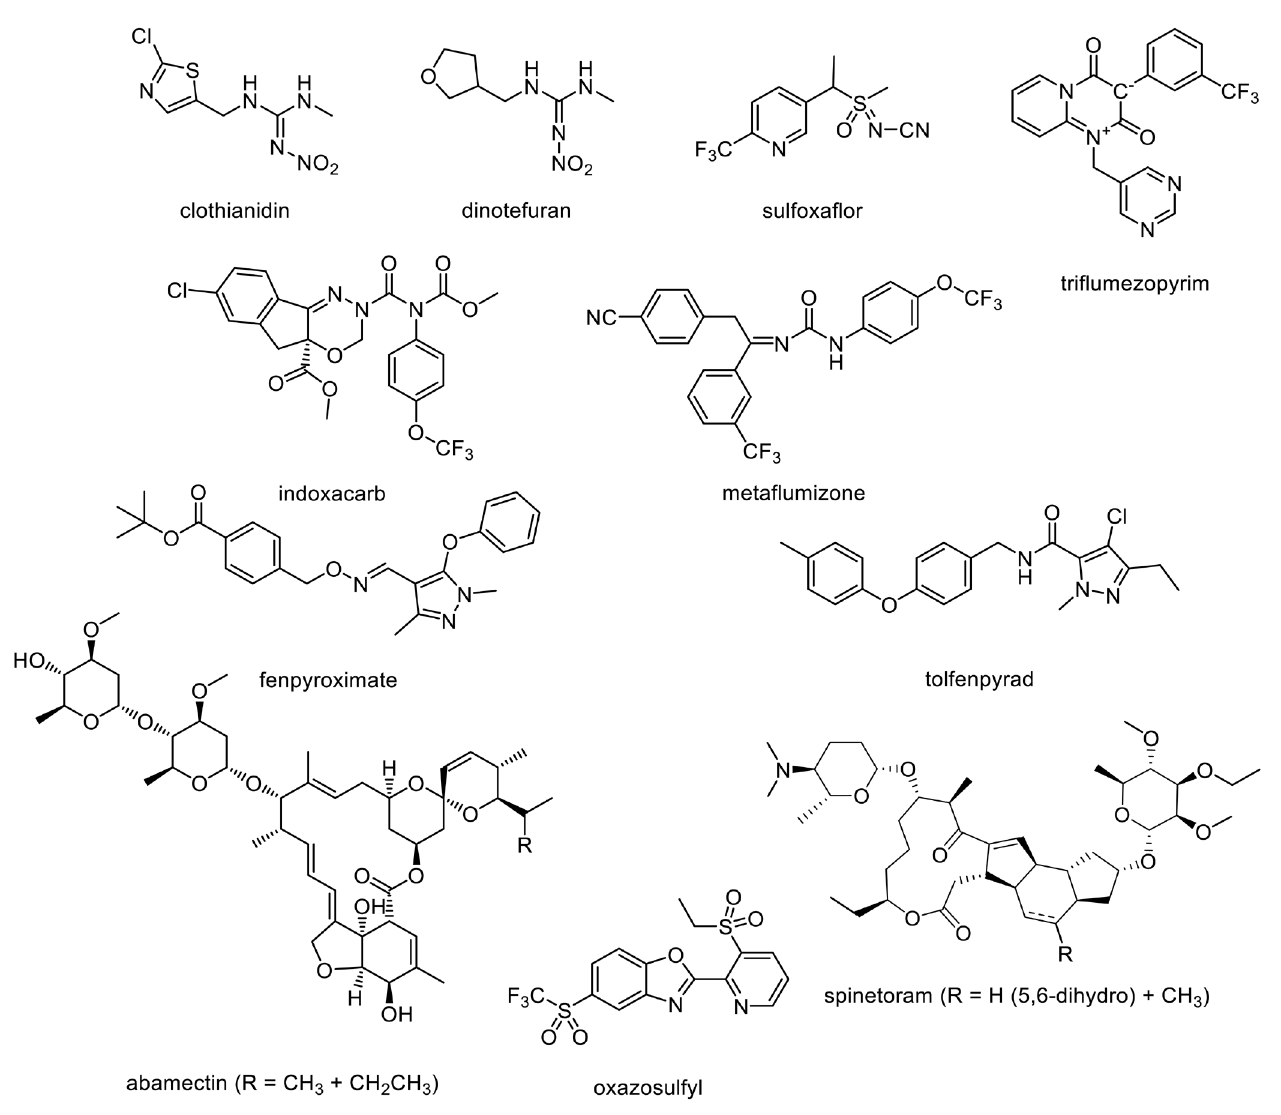
Figure 5. Chemical structures of the shortlisted compounds. From the 40 compounds taken through the testing cascade for repurposed pesticides, 11 are highlighted as potentially suitable for use against mosquito vectors of malaria in an insecticide treated net. Their chemical structures are presented here. Compounds are arranged by IRAC MoA class, class 4 Nicotinic acetylcholine receptor competitive modulators on the first row, class 22 Voltage-dependent sodium channel blockers on the second, and mitochondrial complex 1 electron transport inhibitors on the third. Abamectin is Class 6, a glutamate-gated chloride channel (GluCl) allosteric modulator, spinetoram is Class 5, a nicotinic acetylcholine receptor (nAChR) allosteric modulator – Site I. Oxazosulfyl is not listed by